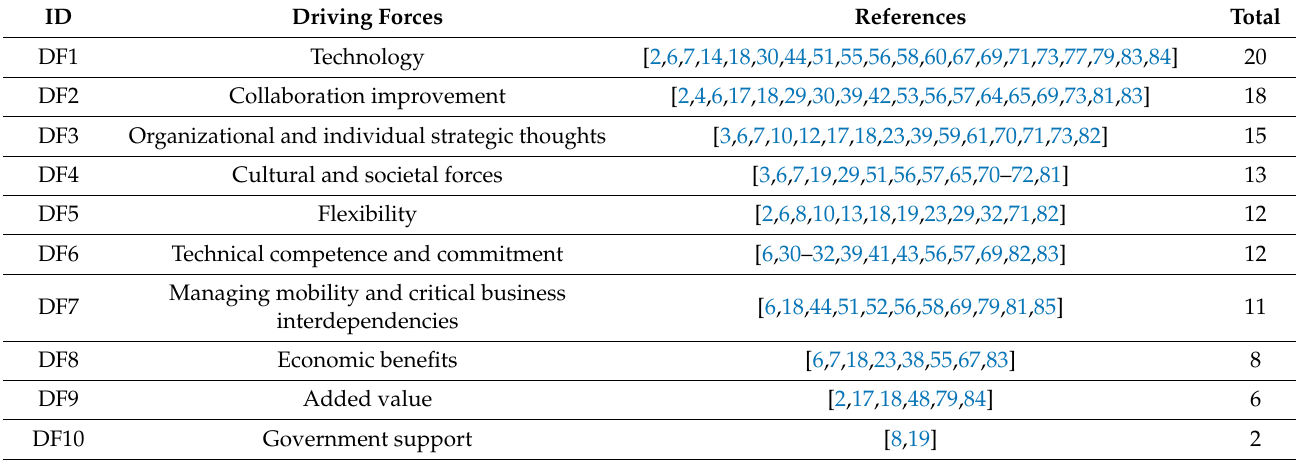
Table 7. RW driving forces elicited from the performed